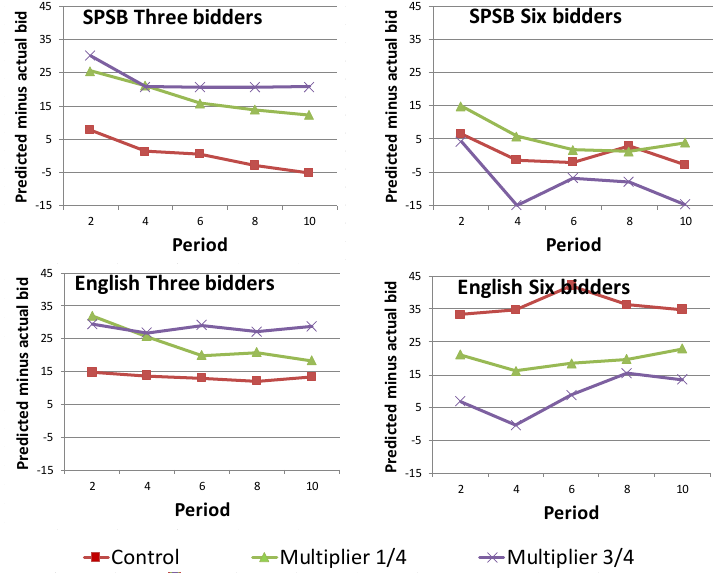
Figure 2. Extent of Underbidding over time in SPSB and English